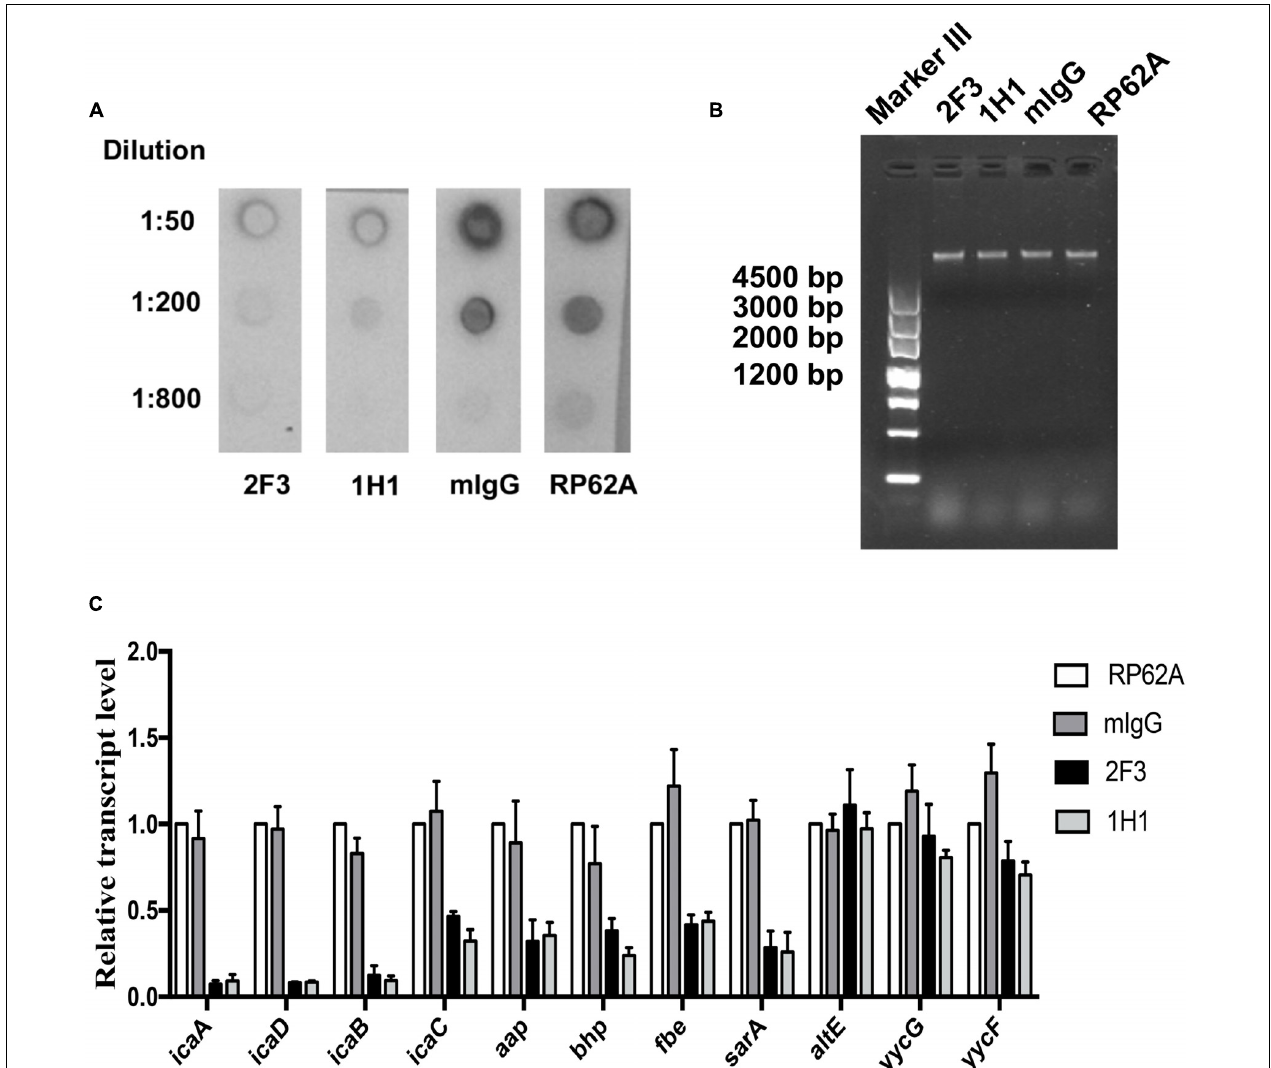
FIGURE 3 | Effect of YycG ex mAbs on EPS synthesis and transcription of biofilm-related genes of S. epidermidis RP62A. Overnight cultures of S. epidermidis RP62A were diluted in TSB containing 160 µ g/mL YycG ex mAbs and incubated at 37 ◦ C for 6 h. (A) Effect of YycG ex mAbs on PIA synthesis. (B) Effect of YycG ex mAbs on eDNA release. eDNA was isolated and analyzed on 1% agarose gels. (C) Effect of YycG ex mAbs on transcriptional levels of biofilm-related genes. All reactions were performed in triplicate, with housekeeping gyrase B subunit gene ( gyrB ) used as an internal standard. RP62A, untreated; mIgG, normal mouse IgG